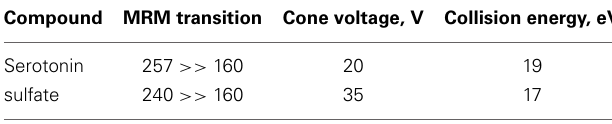
Table 2 | MS/MS parameters of serotonin